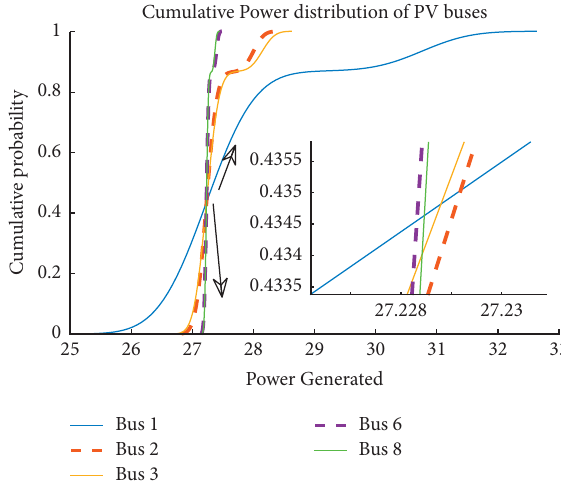
Figure 11: Cumulative power distribution at buses 3–5.